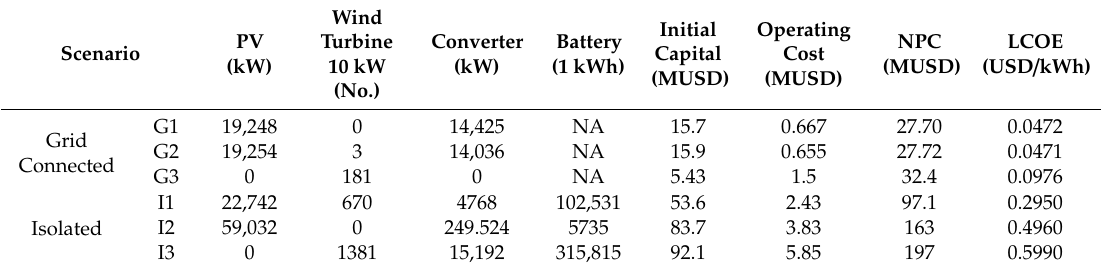
Table 1. Components sizing and economic results of grid-connected and isolated scenarios.